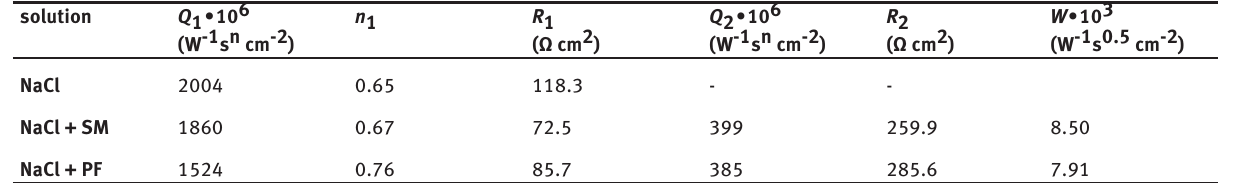
Table 3: Impedance parameters for Fe electrode in 0.1 mol L -1 NaCl solution in the absence and presence of SM and PF. solution